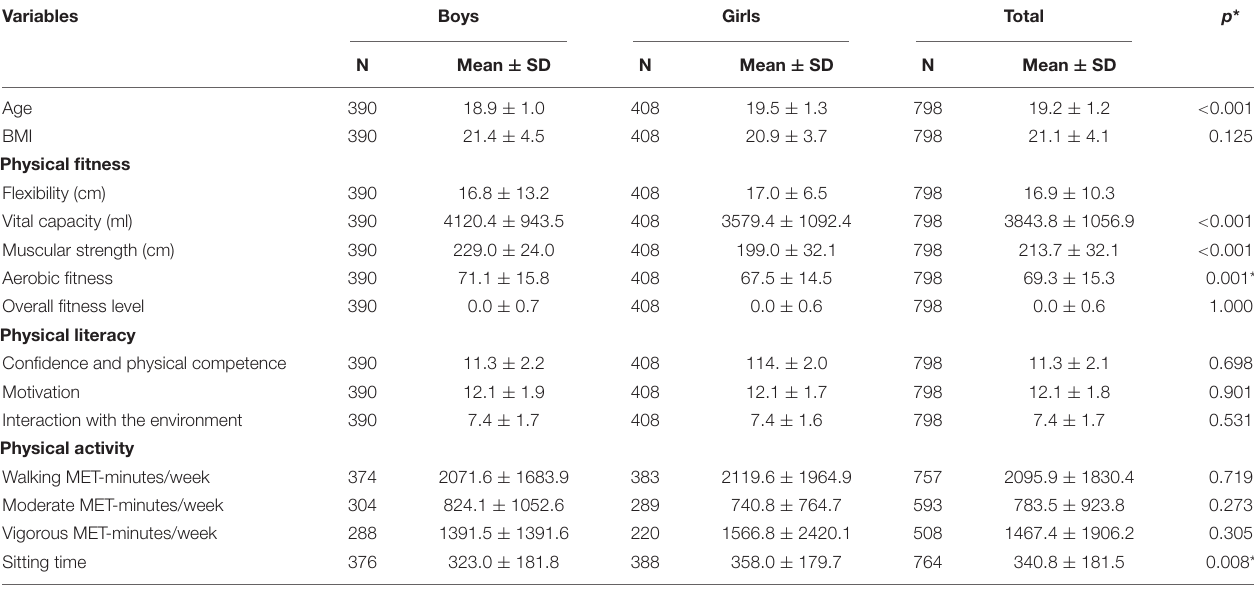
TABLE 1 | Descriptive statistics of the study sample.